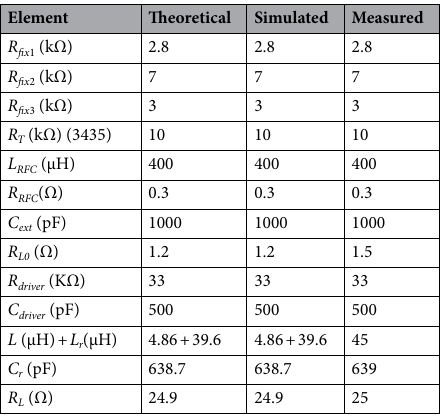
Table 3. The elements value of the inverter and compensation circuit.